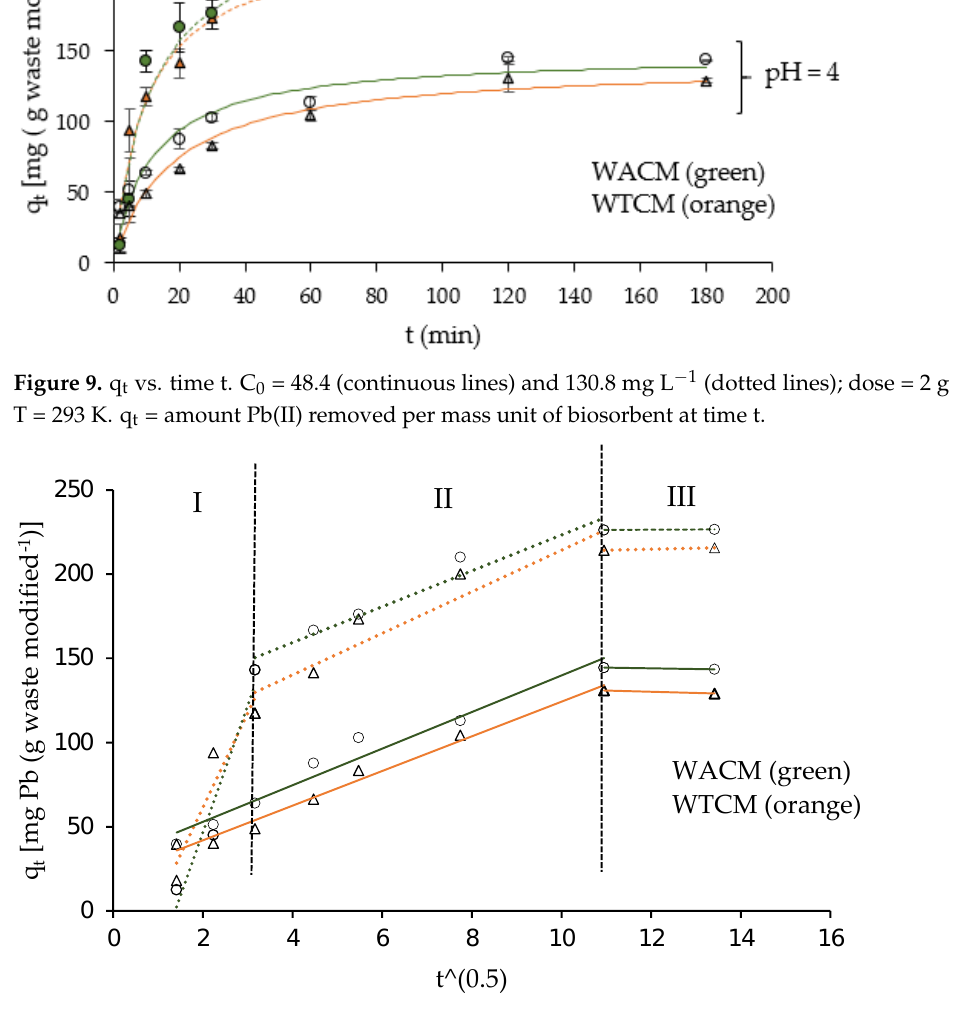
Figure 10. Weber–Morris plots of Pb(II) adsorption on WACM and WTCM. C 0 = 48.4 (continuous lines) and 130.8 mg L −1 (dotted lines).